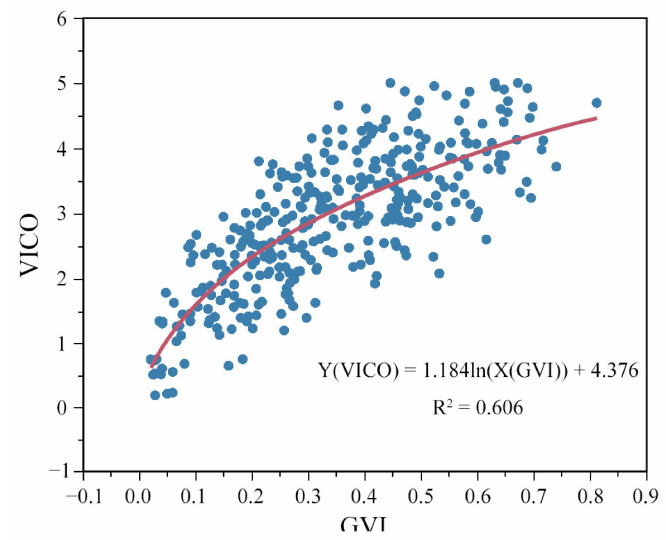
Figure 12. Scatter diagram of GVI and